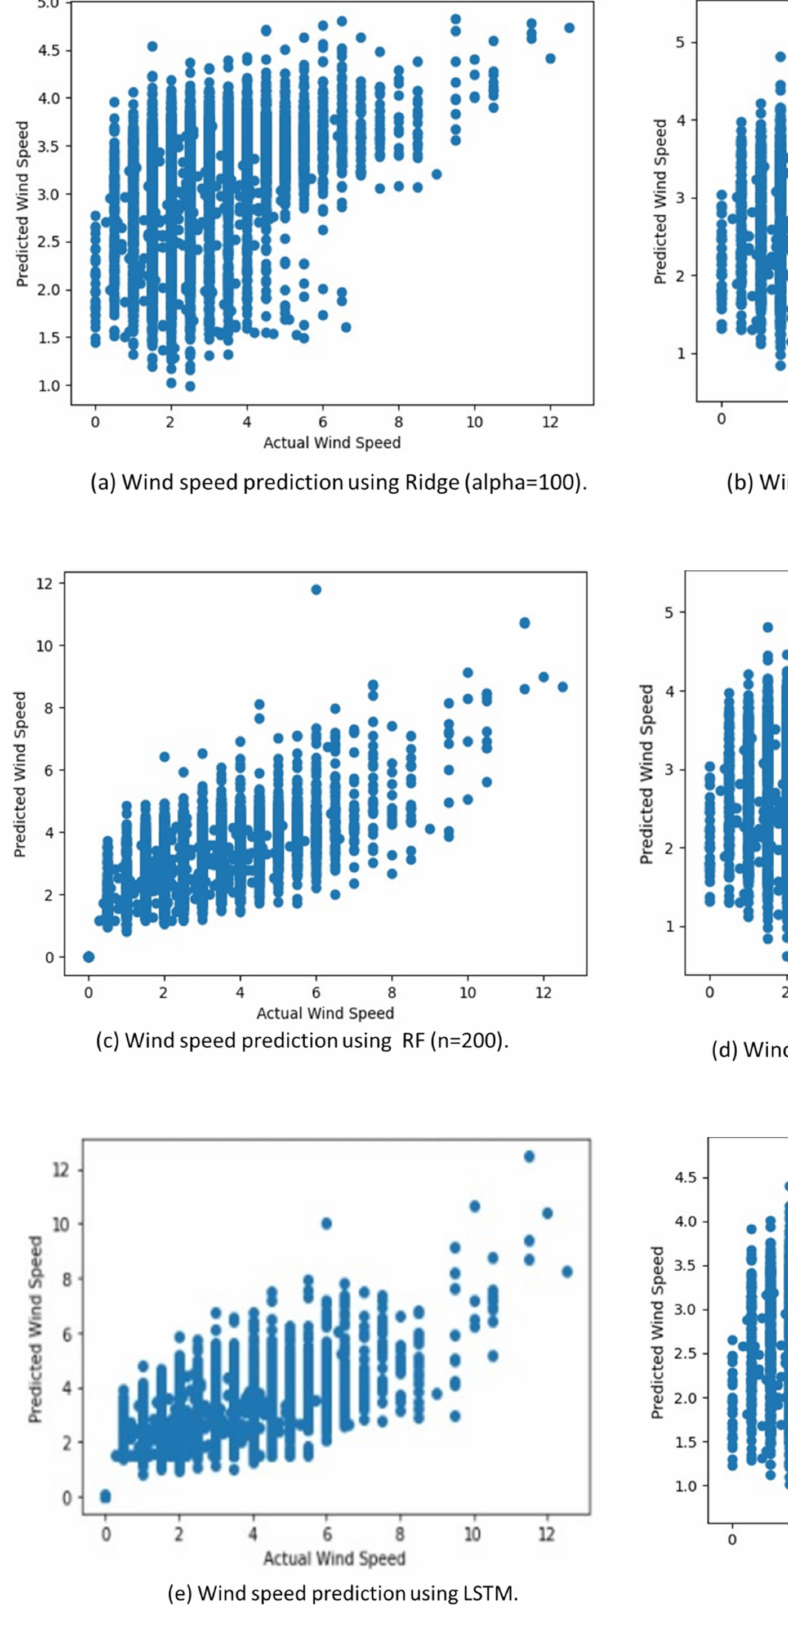
Figure 5. Machine-learning models prediction